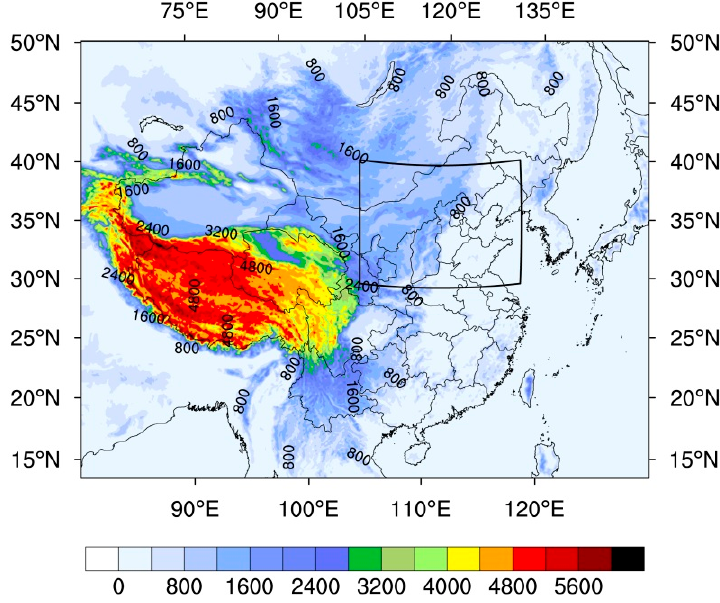
Figure 1. RMAPS-ST domains with topographic features.